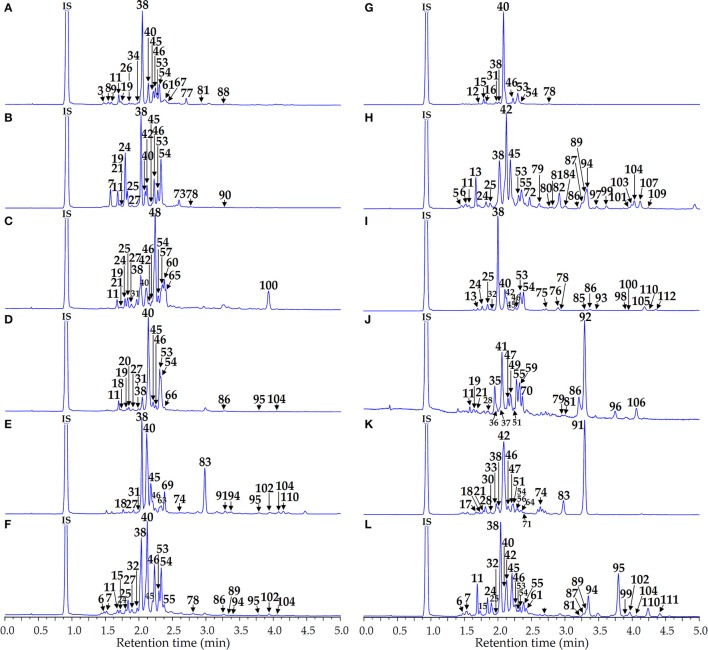
HPLC-DAD chromatograms of the flavonoid-enriched SPE fractions of Artemisia extracts at 280 nm. (A)
A. anethifolia; (B)
A. commutata; (C)
A. desertorum; (D)
A. integrifolia; (E)
A. latifolia; (F)
A. leucophylla; (G)
A. macrocephala; (H)
A. messerschmidtiana; (I)
A. palustris; (J)
A. sericea; (K)
A. tanacetifolia; (L)
A. umbrosa. Compounds are numbered as listed in Table 2. IS, internal standard (scopoletin-7-O-neohesperidoside).